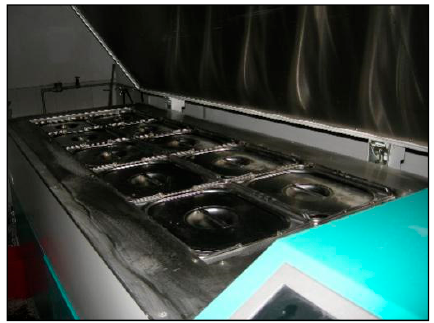
Figure 3. Collider Detector at Fermilab (CDF) test machine.